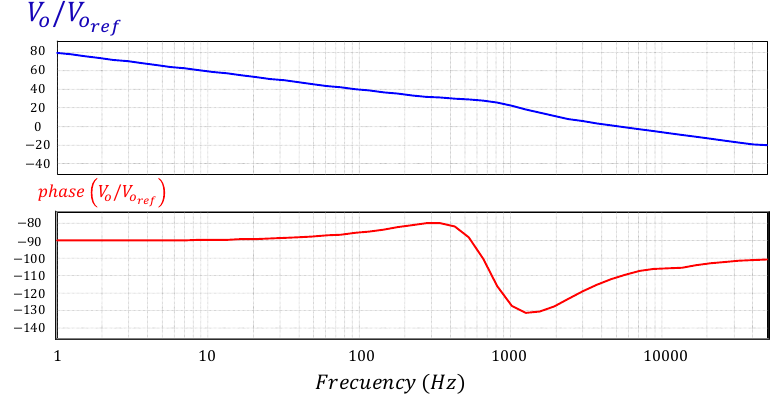
Energies 2019 , 12 , x Figure 7. Open-loop Bode diagram of the system. Figure 7. Open-loop Bode diagram of the system.